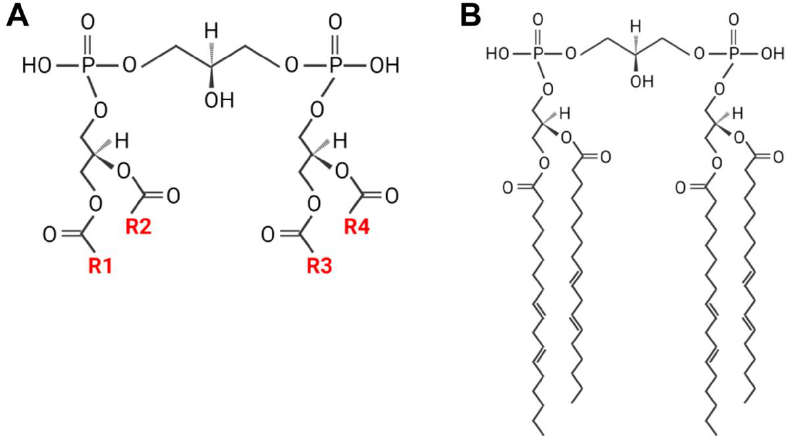
Figure 1. The structure of CL ( A ) and TLCL ( B ). CL has four fatty acyl chains designated R1–R4.